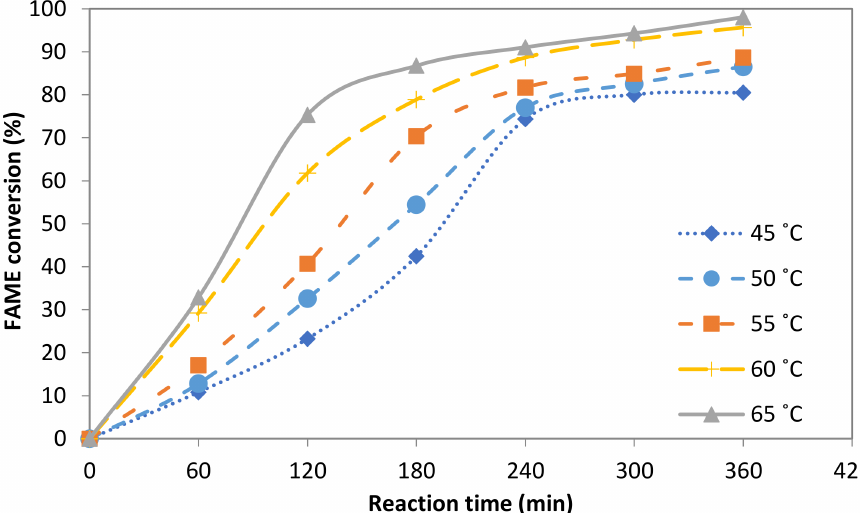
Figure 6. Evaluation of FAME conversion with time at different temperatures (catalyst loading 4 wt.%, methanol to oil molar ratio 9:1, stirring rate 700 rpm, reaction time 0–6